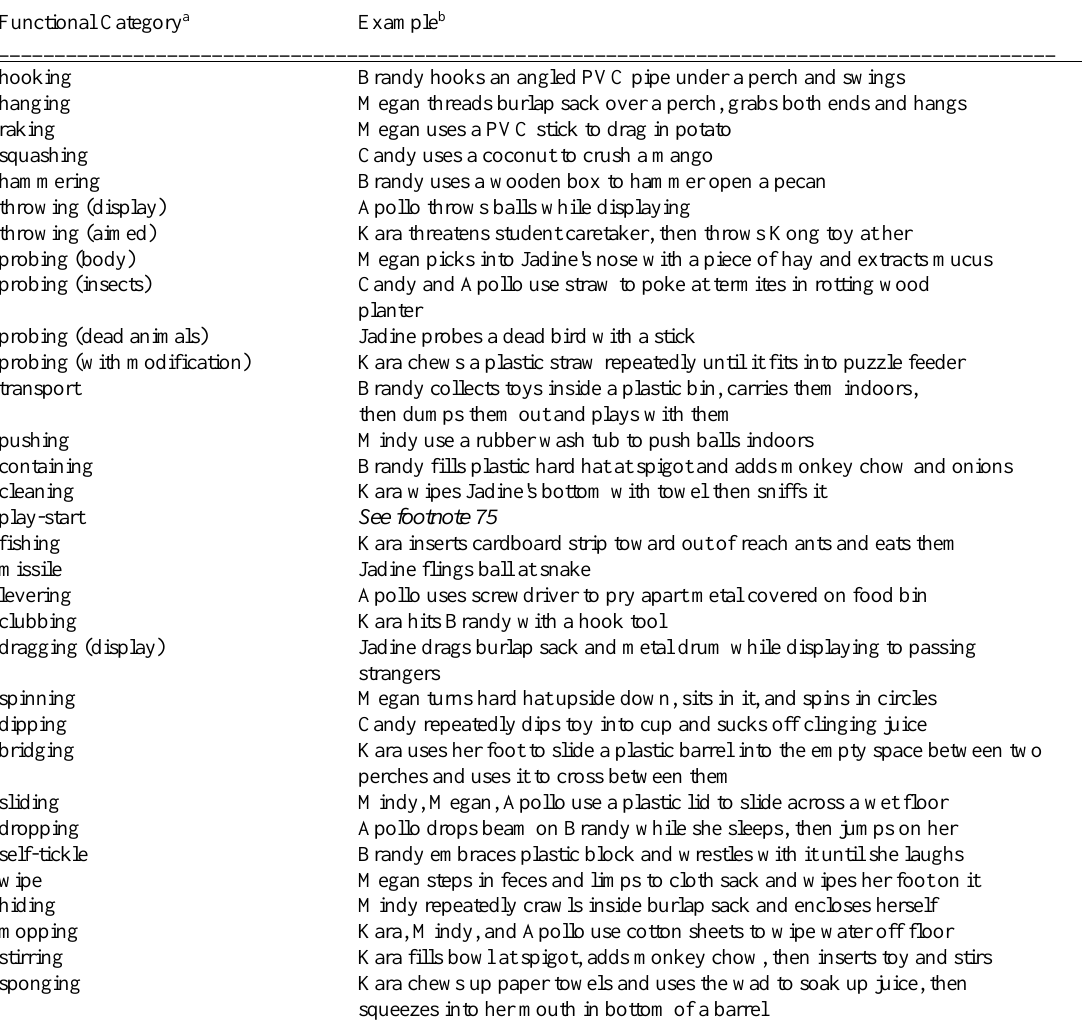
Categories of Spontaneous Tool-Using (Illustrated with One Example Each) Observed During Informal Observations of Candy and Her